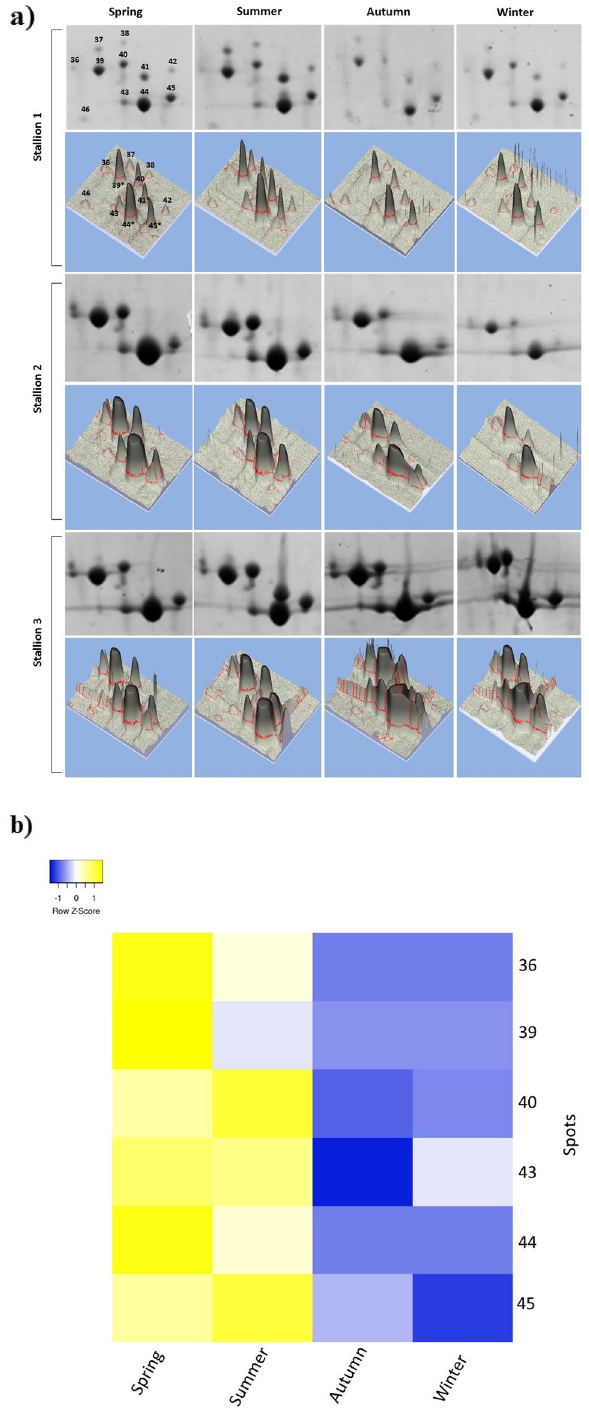
Figure 4. Intensity of kallikrein proteoforms in different climatic seasons. ( a ) Spot region in kallikrein-enriched two- dimensional gels (Spots 36–46) and the corresponding three-dimensional association. The images of the complete gels from which the spots were cut and are presented in the supplementary information file, highlighted in the red frames. ( b ) Heatmap of spots in the region enriched with kallikreins present in the two-dimensional gels of the three stallions. Yellow blocks indicate high protein abundance and blue blocks low protein abundance. The numbers of the points relative to Fig. 3b are on the right side of the heatmap. In ( a ) the ImageMaster 2D Platinum 7.0 software (GE Healthcare, https:// image master- 2d- plati num. softw are. infor mer. com/7. 0/) was used to create the 2D and 3D images by selecting the kallikrein-enriched region; figures were edited manually, obeying the size proportion for each treatment. In ( b ) the online Heatmapper software (http:// heatm apper. ca/ expre ssion/) was used, in which the mean %vol data of the spots identified as kallikreins were submitted only for Animals 1 and 2 (for the spots common to both animals); the data were normalised before being sent to the software, taking into account the spots corresponding to the spring season as a